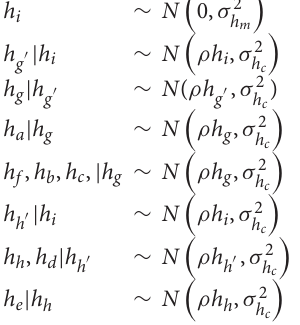
FIGURE 1 | Phylogenetic relationship of haplotypes in Table 1 .